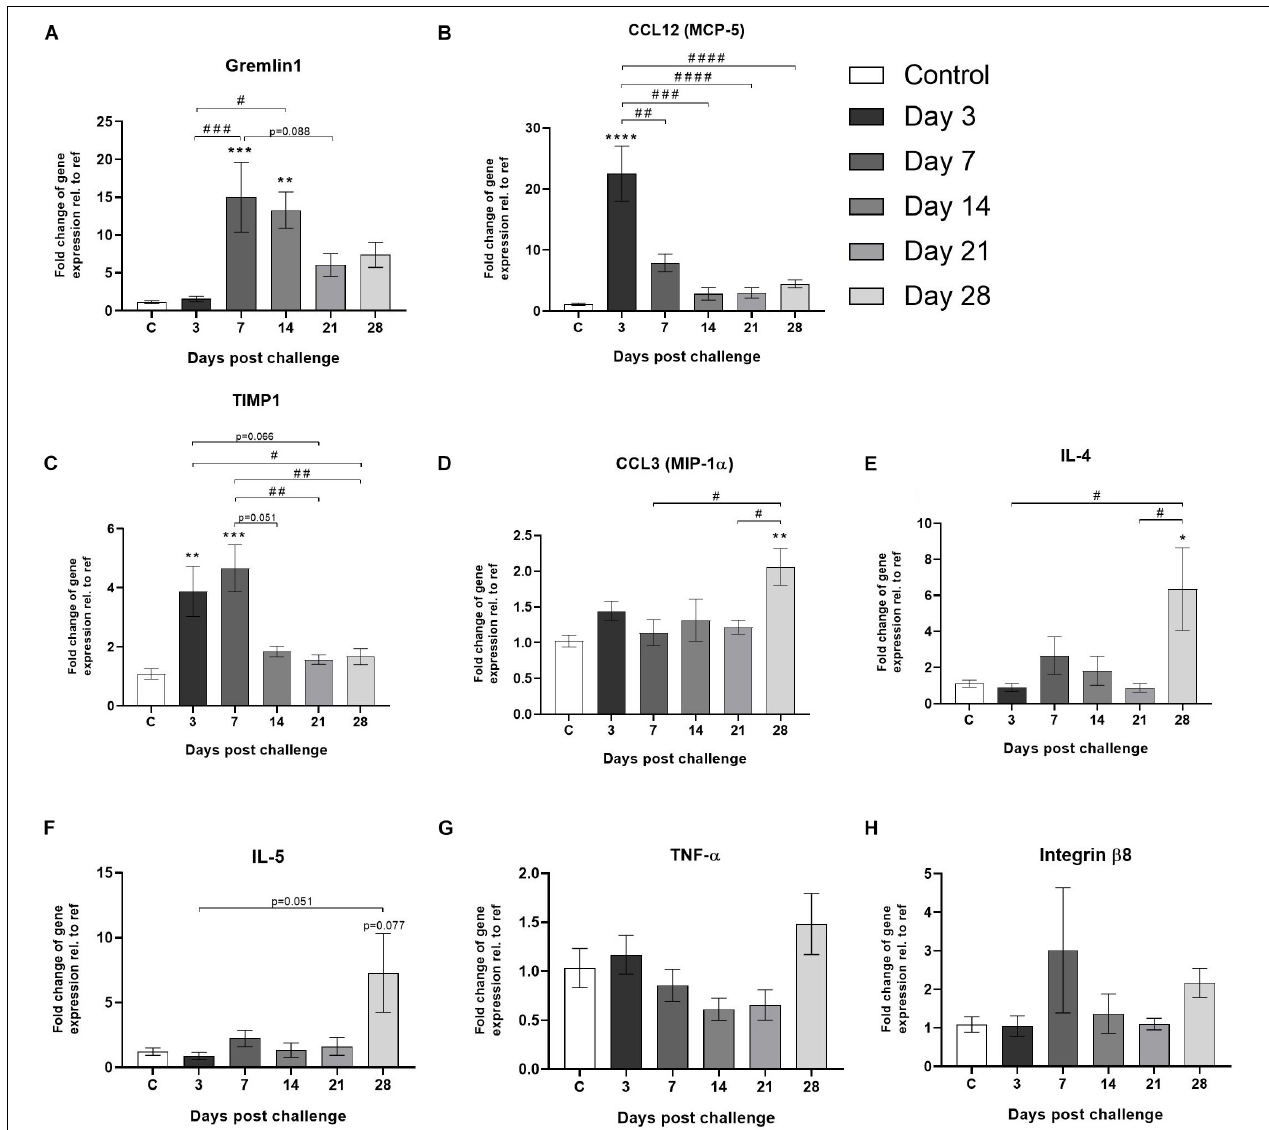
FIGURE 7 | Gene expression of markers involved in lung injury and wound healing. Gene expression of (A) gremlin1, (B) CCL12 (MCP-5), (C) TIMP1, (D) CCL3 (MIP-1 α ), (E) IL-4, (F) IL-5, (G) TNF- α , and (H) integrin- β 8, are all presented as mean ± standard error of the mean (SEM). All samples from the bleomycin group are related to the mean of control and normalized to the geometric mean of five different reference genes. Each presented group/time point contains n = 4 – 8. Significance is indicated by * when p < 0.05; p < 0.01 by **; p < 0.001 by *** and p < 0.0001 by ****, when comparing bleomycin towards the saline control. The comparison of various time points between bleomycin-challenged groups is expressed as # when p < 0.05; ## when p < 0.01; ### when p < 0.001 and #### when p <